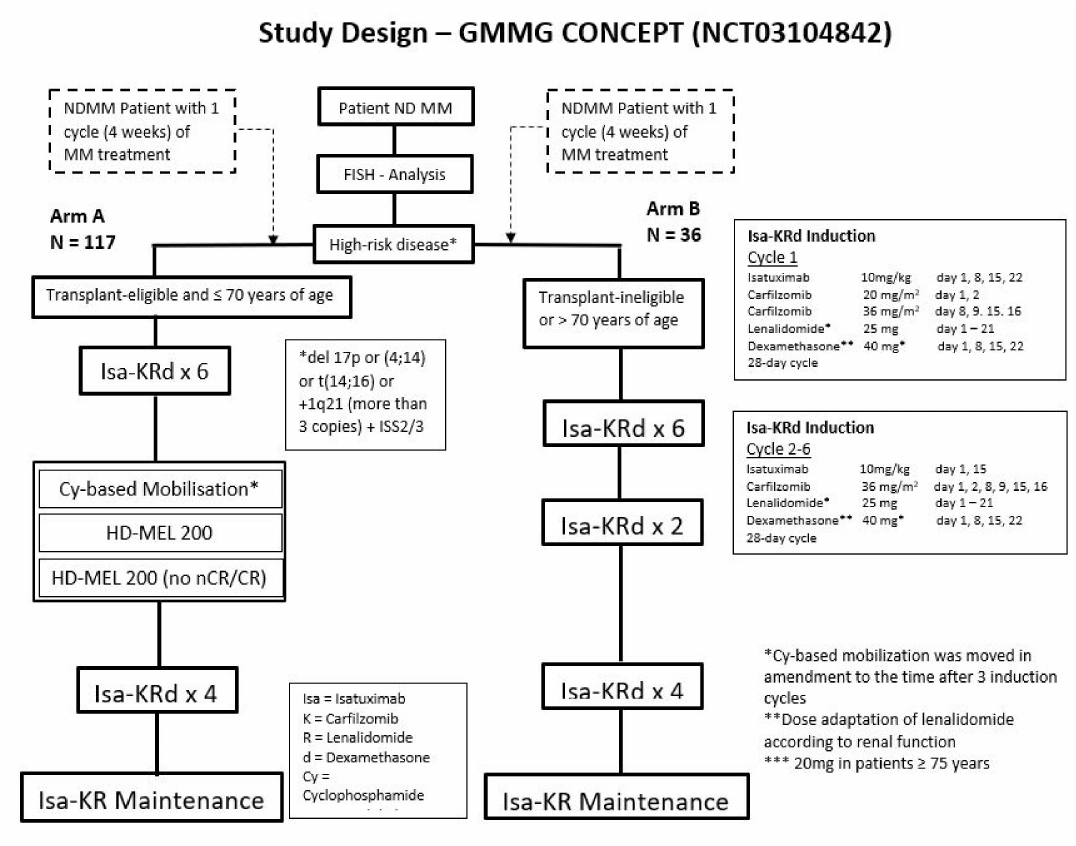
Figure 1. Study design and induction regimen of the GMMG CONCEPT